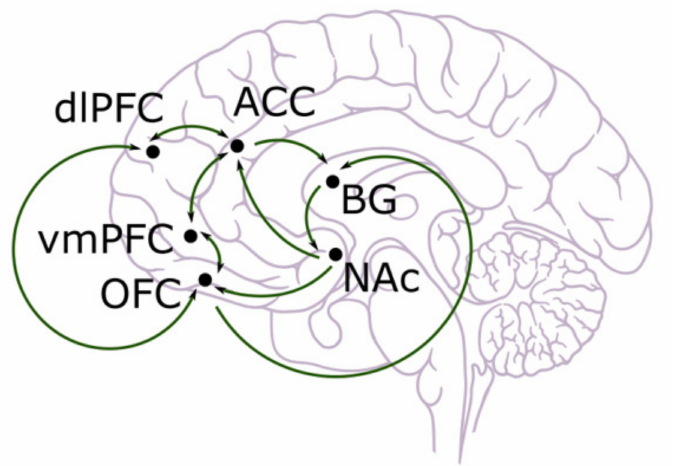
Figure 1. Anatomical illustration of dorsolateral prefrontal cortex (dlPFC), anterior cingulate cortex (ACC), ventromedial prefrontal cortex (vmPFC), orbitofrontal cortex (OFC), basal ganglia (BG), and nucleus accumbens (NAc)